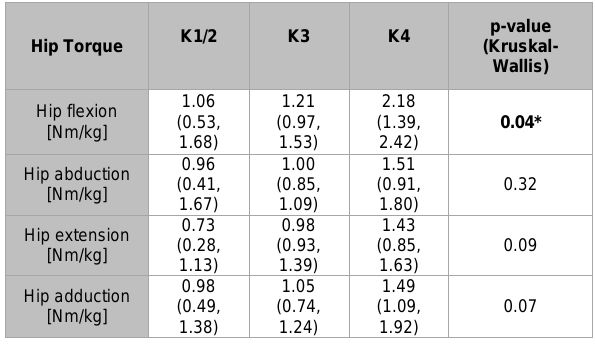
Table 2: Maximum hip torque presented as median and IQR (25 th percentile, 75 th percentile).